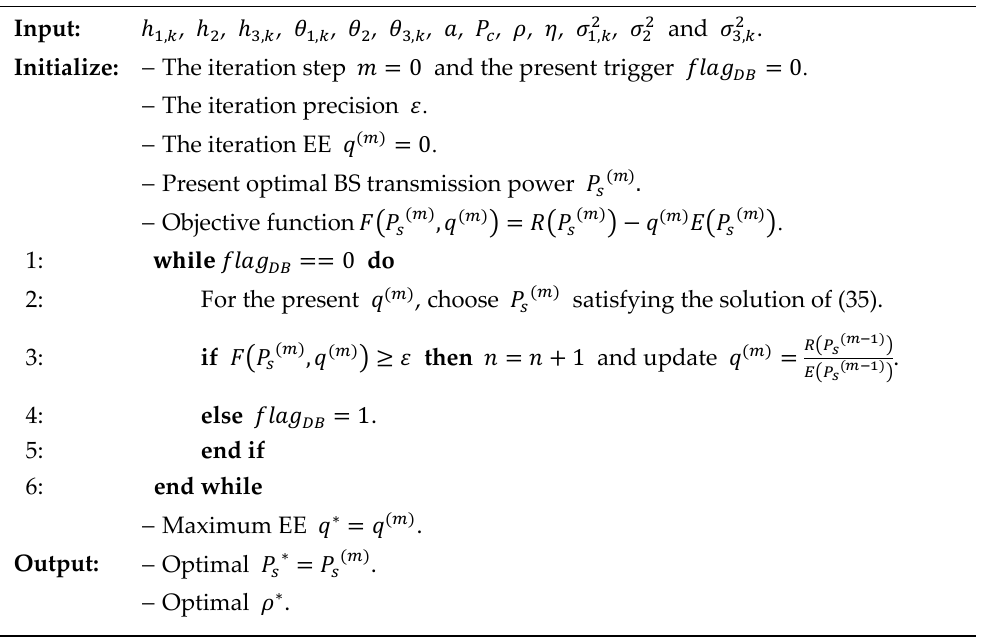
Algorithm 1. DinkelBach iterative algorithm for EE optimization in cooperative mode. Algorithm 1 DinkelBach iterative algorithm for EE optimization in cooperative